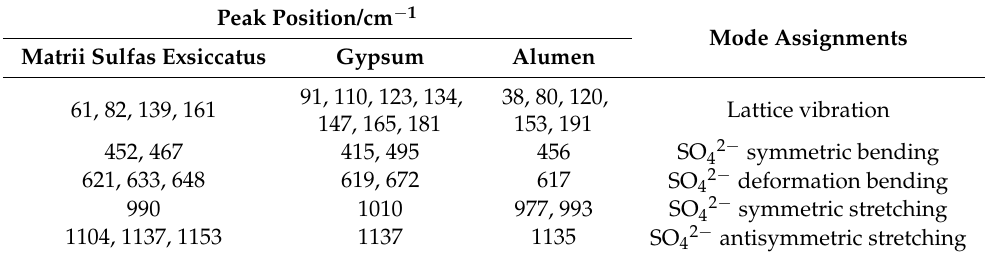
Table 3. Vibrational mode assignments for the Raman peaks of the sulfates.